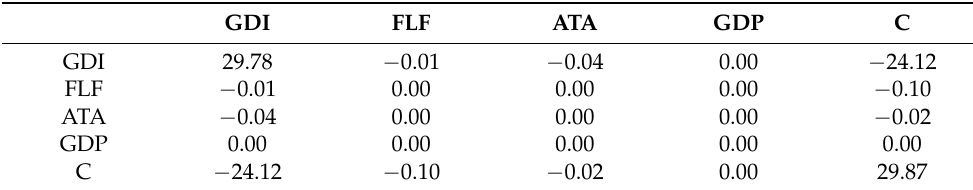
Table 3. Correlation between variables.